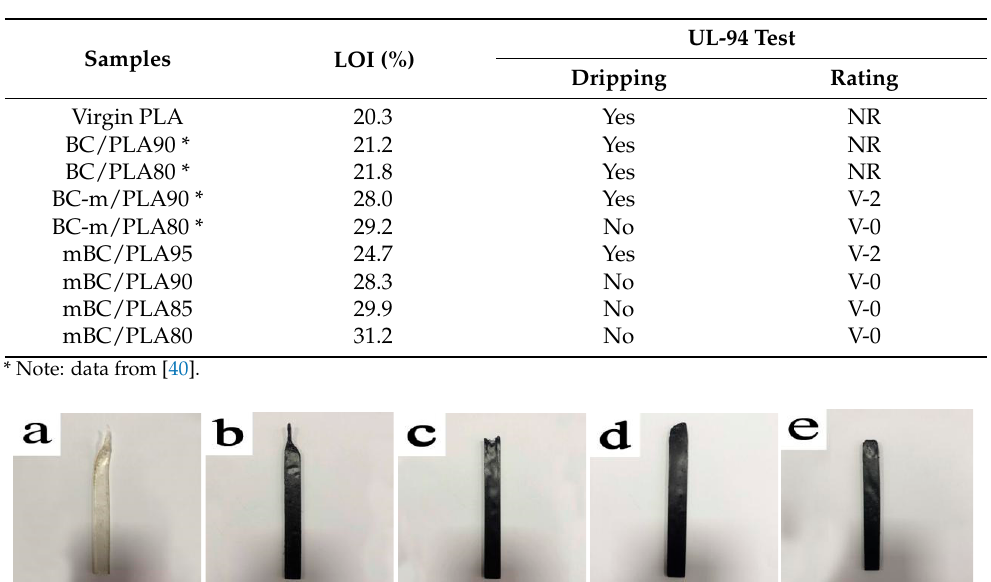
Table 4. LOI and UL-94 results.